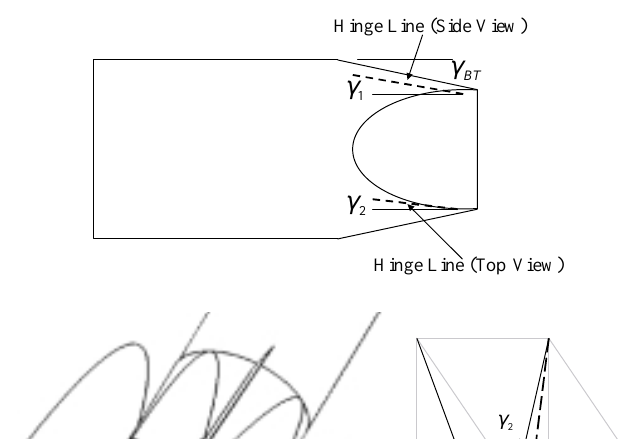
Fig. 3. Schematic of fin opening.